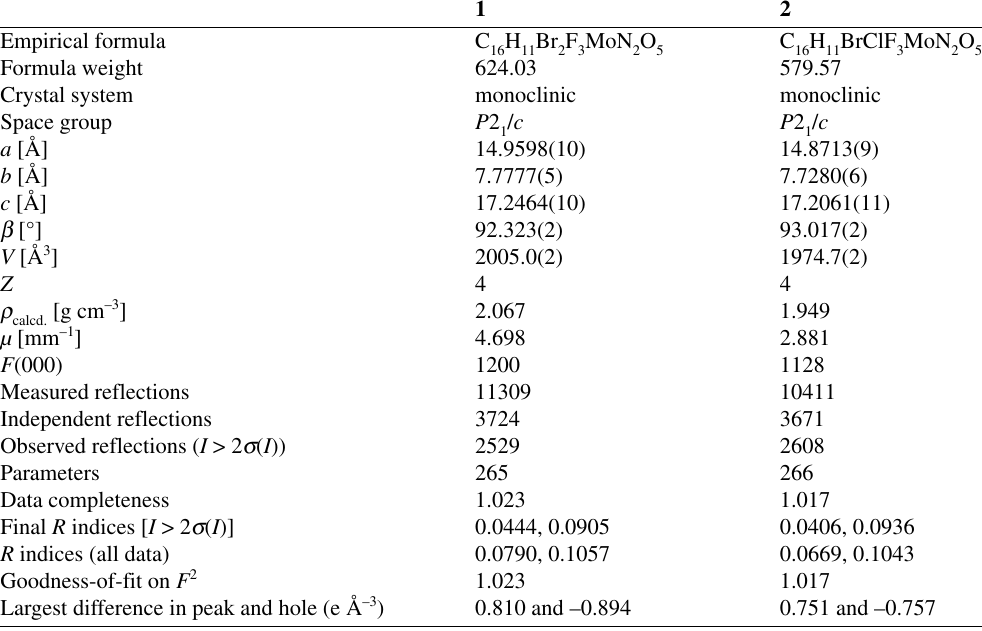
Table 1. Crystallographic Data for the